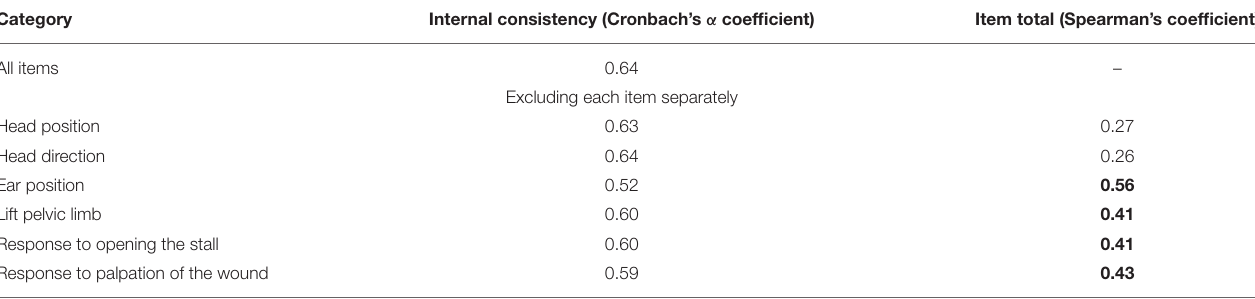
TABLE 10 | Internal consistency and item-total correlation of the DOPS. Category